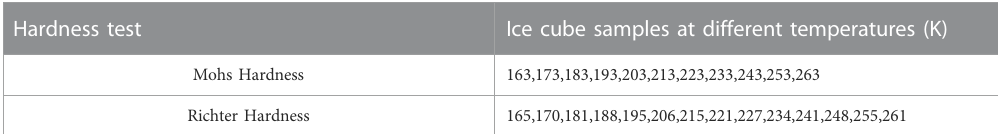
TABLE 2 Physical parameters of the substrate.